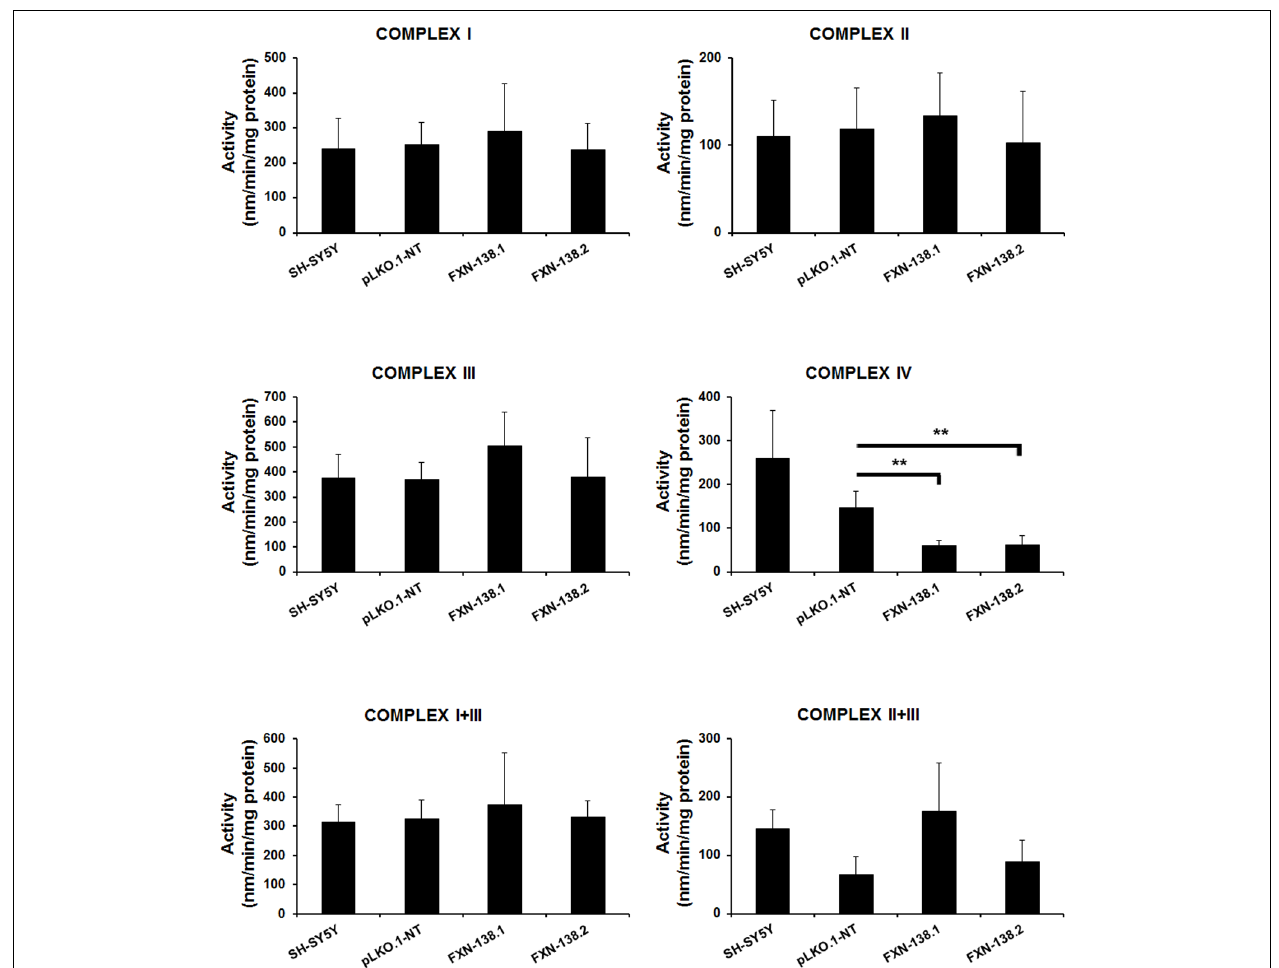
FIGURE 4 | Enzymatic activity analysis of the ETC in SH-SY5Y clones. Wild-type SH-SY5Y, pLKO.1-NT, FXN-138.1, and FXN-138.2 cells were grown for 1 month. Mitochondria were isolated and used to determine the enzymatic activity of Complex I, II, III, IV, I + II,